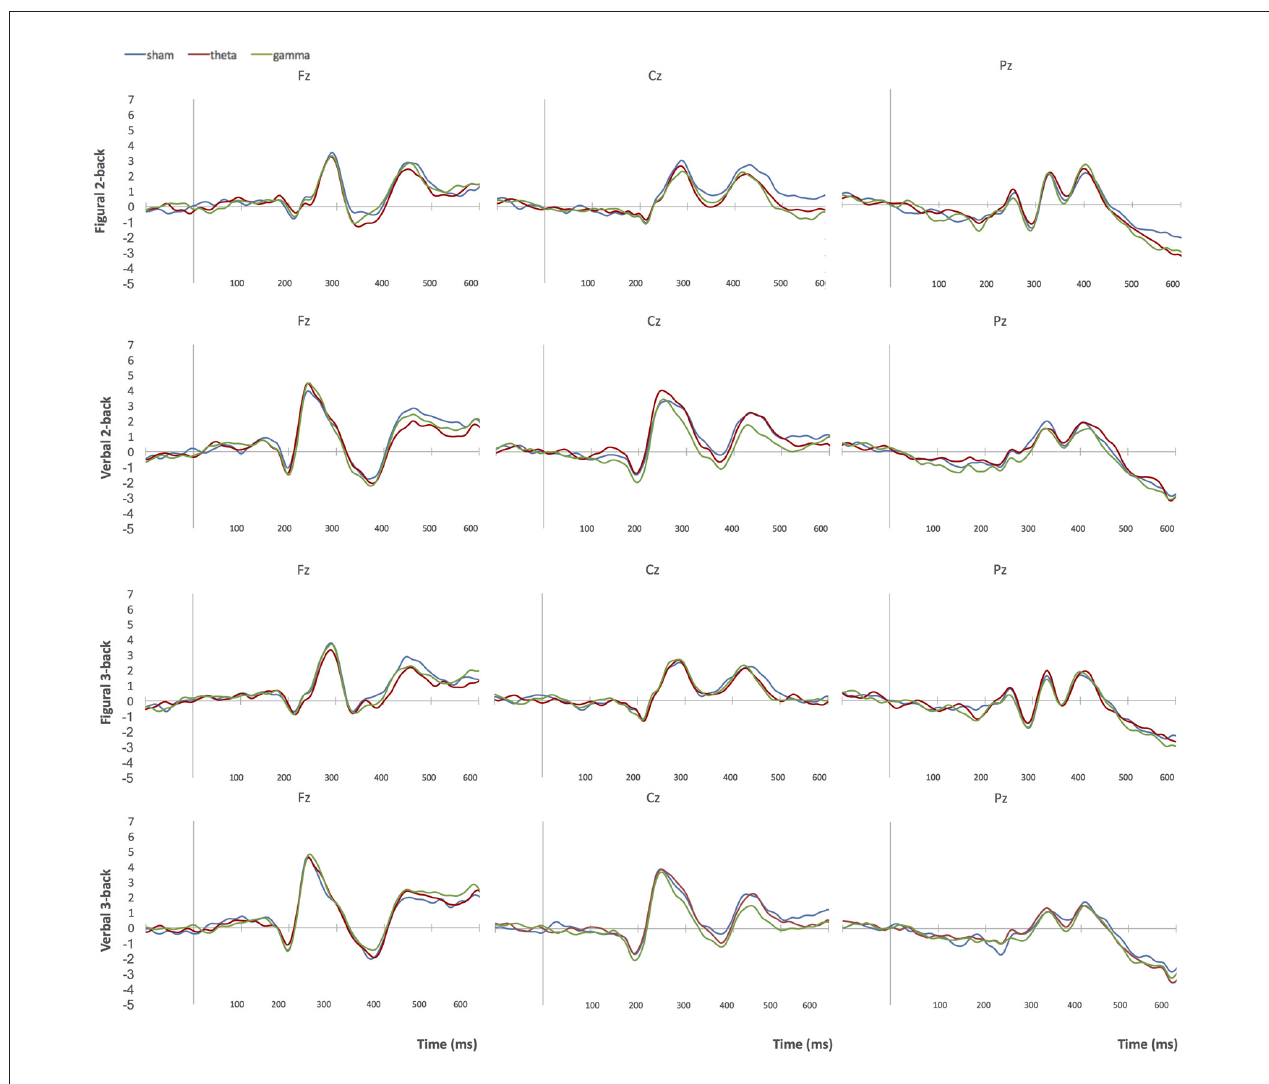
FIGURE 5 | Grand-average ERPs at midline electrodes during performance on n-back tasks in Group 3 (right frontoparietal stimulation). Blue = sham tACS session, red = theta tACS session, green = gamma tACS